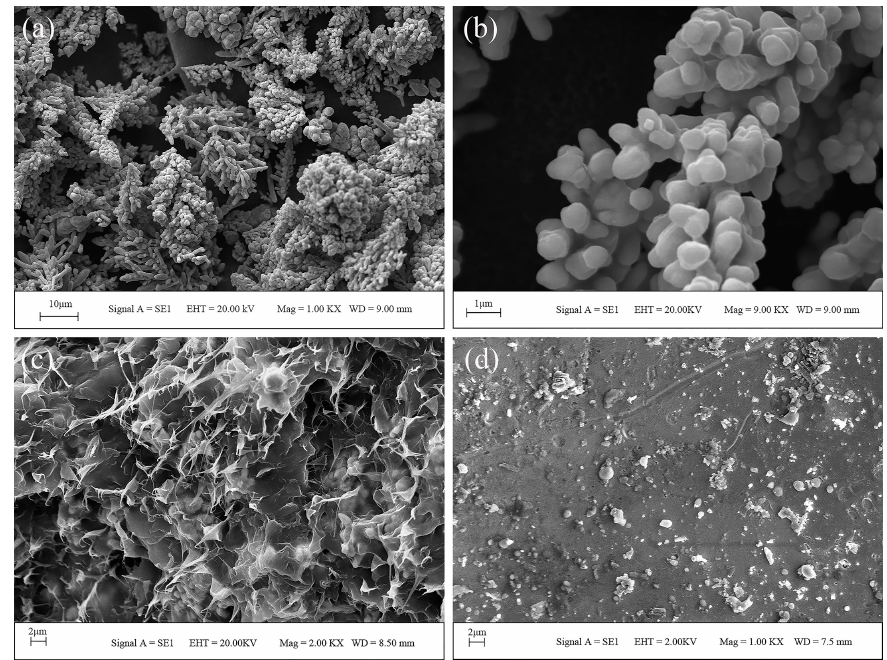
Figure 2. SEM image of the Cu powder with the magnifying power of 1 kx ( a ); the Cu powder with the magnifying power of 9 kx ( b ); cross section of the green body ( c ); surface of the sintered part with heating rate (3 °C/min), highest temperature (1083 °C), holding time (3 h) ( d ). Table 4. Characteristics of Cu powders used in this study.